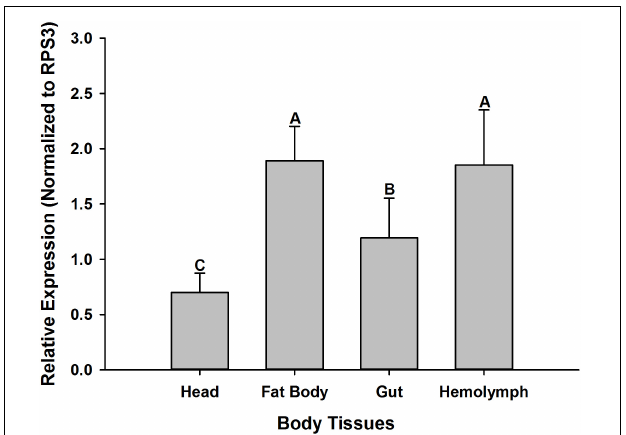
FIGURE 5 | Expression profiles of OnRelish across different tissues in the absence of microbial challenge. The data were presented as Mean ± SD ( n = 3). Statistical significance is indicated by different letters above the bar at P <